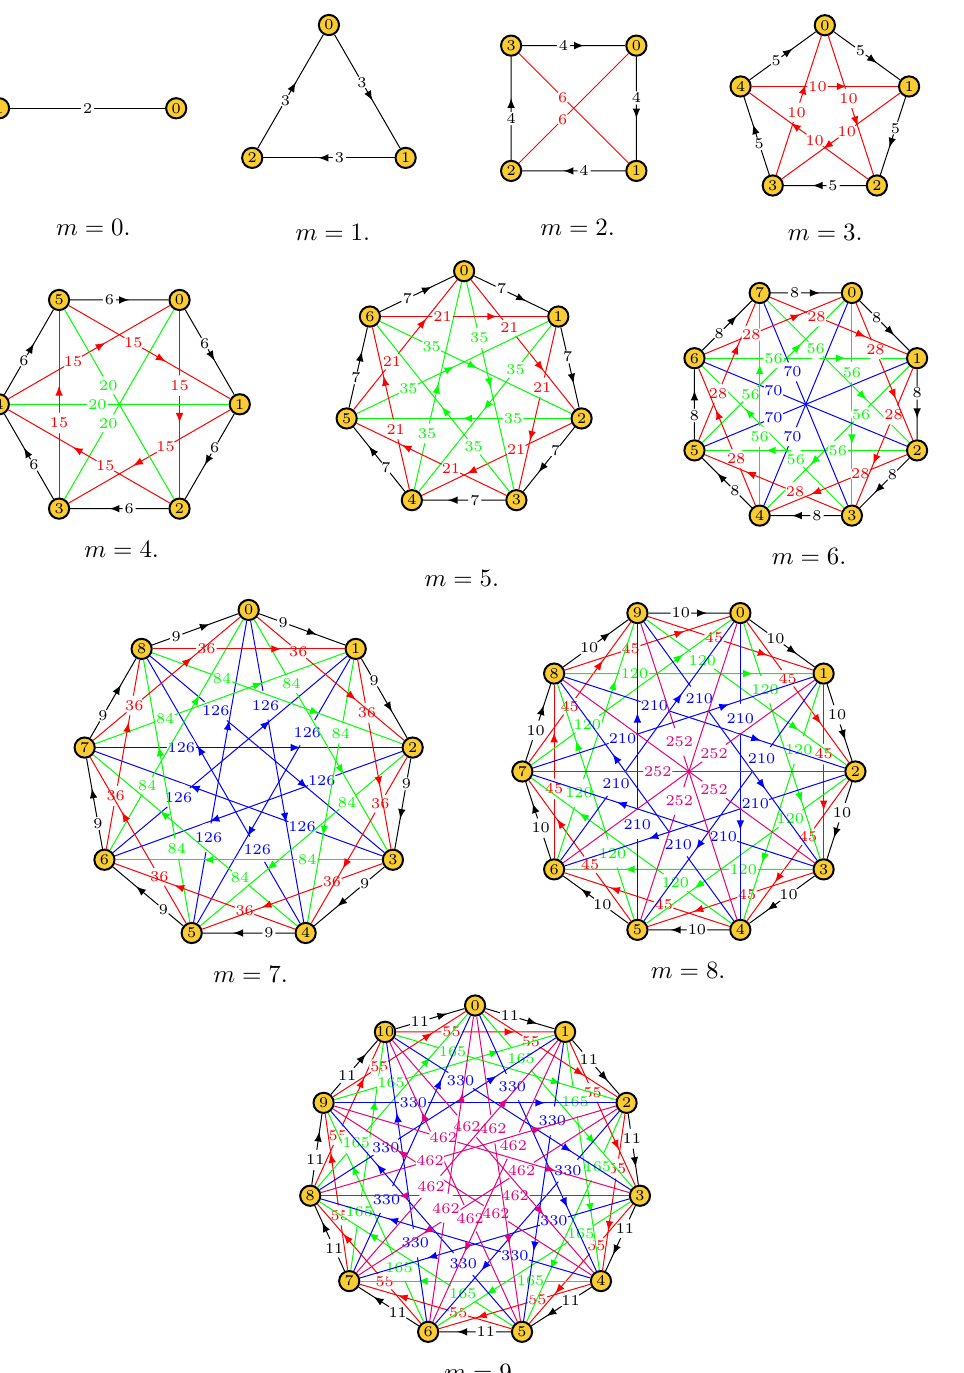
Figure 4. Quivers for the C m +2 = Z m +2 orbifolds. Black, red, green, blue and purple correspond to degree 0, 1, 2, 3 and 4,